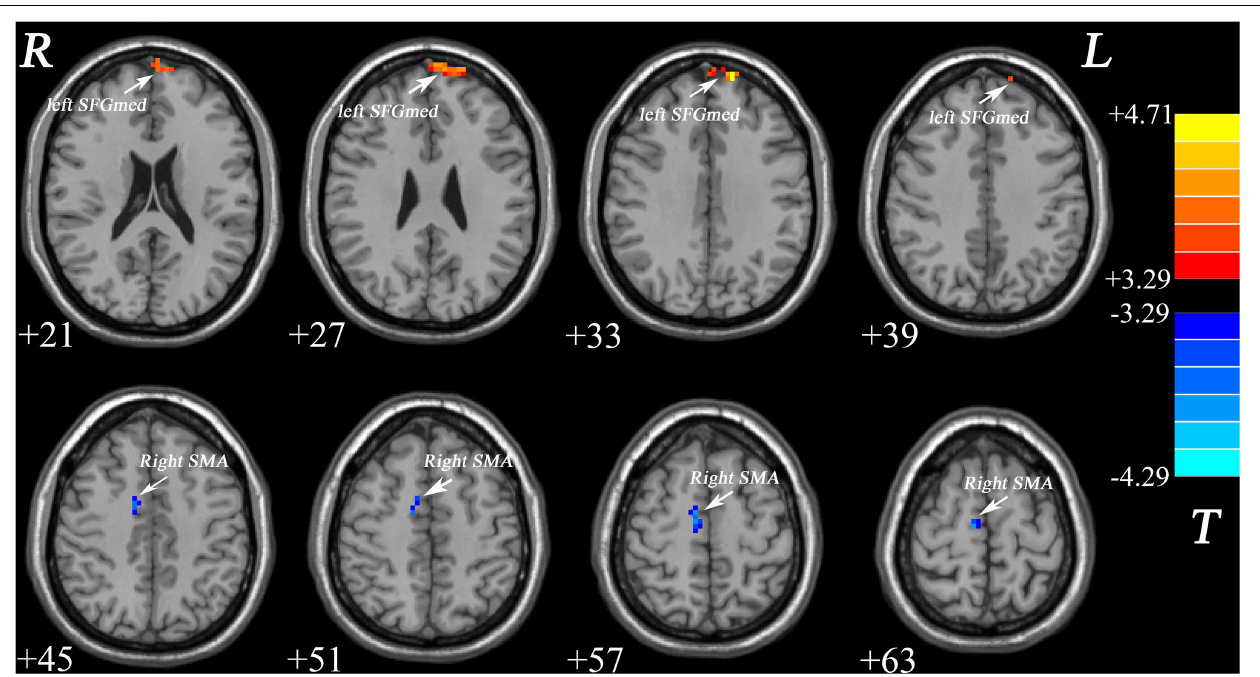
FIGURE 1 | Increased GFC values in the left SFGmed and decreased GFC values in the right SMA were observed in patients with MDD relative to healthy controls. GFC, global-brain functional connectivity; SFGmed, medial superior frontal gyrus; SMA, supplementary motor area; MDD, major depressive disorder.